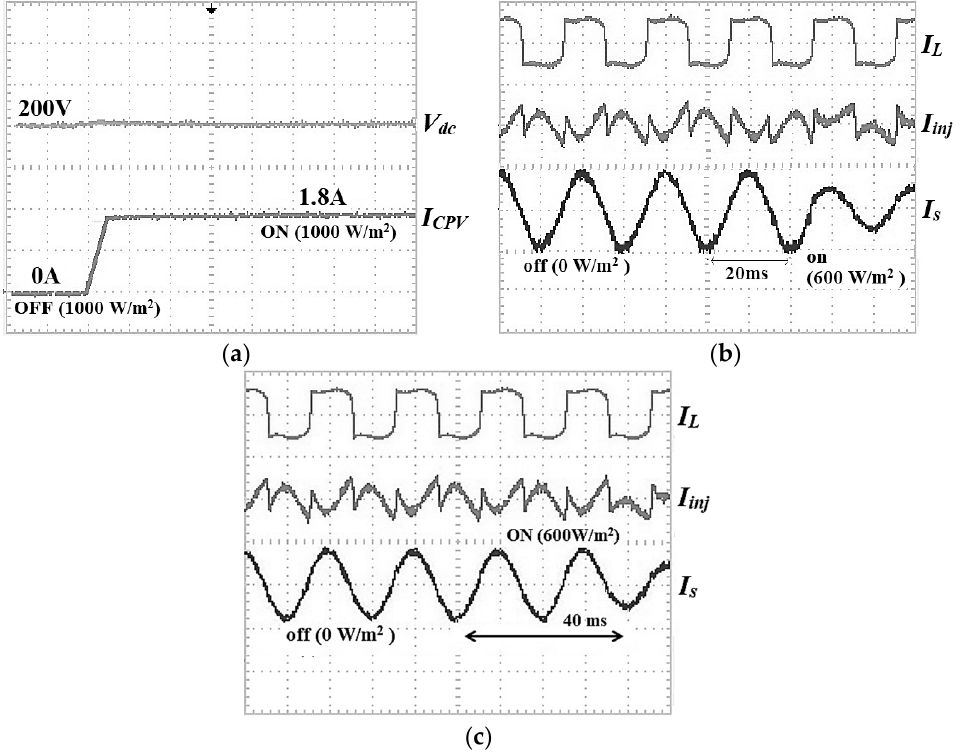
Figure 18. Experimental results of ( a ) the self-charging with step size error cancellation DC link capacitor voltage control algorithm under off–on operation between PV and SAPF, with ( b ) Simpler ADALINE and ( c ) Modified Widrow–Hoff ADALINE current harmonics extraction algorithms covering load current I L (5 A/div), injection current I inj (5 A/div), and source current I s (5 A/div).